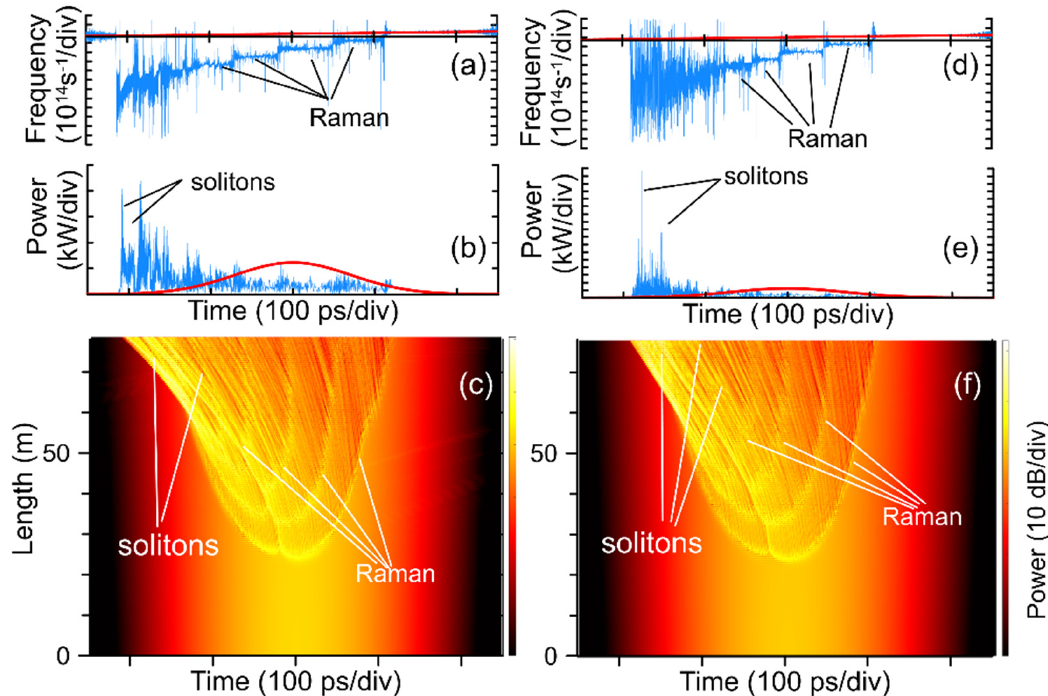
Figure 8. Frequency modulation of radiation at the input (red) and output (blue lines) from fibers with longitudinally decreasing ( a ) and increasing ( d ) diameters. Time envelopes of the initial pulse (red) and output radiation (blue lines) from fibers with longitudinally decreasing ( b ) and increasing ( e ) diameters. The evolution of the pulse power during the propagation of radiation through the fibers with longitudinally decreasing ( c ) and increasing ( f ) diameters.